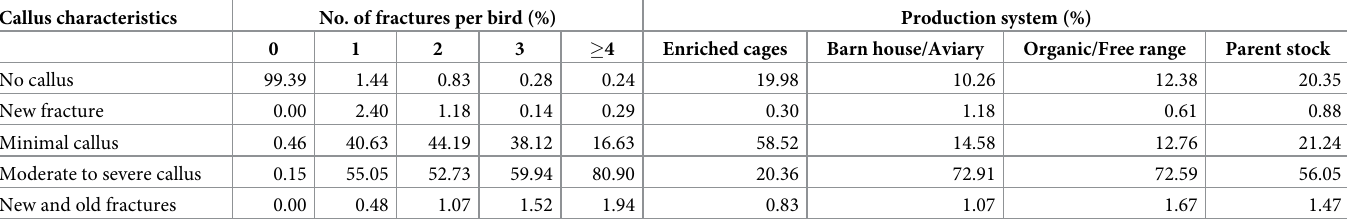
Table 10. Association between callus characteristics and number of fractures per bird (n = 4758) or production system (n = 4760). The distribution is presented as percentages within columns. Callus characteristics